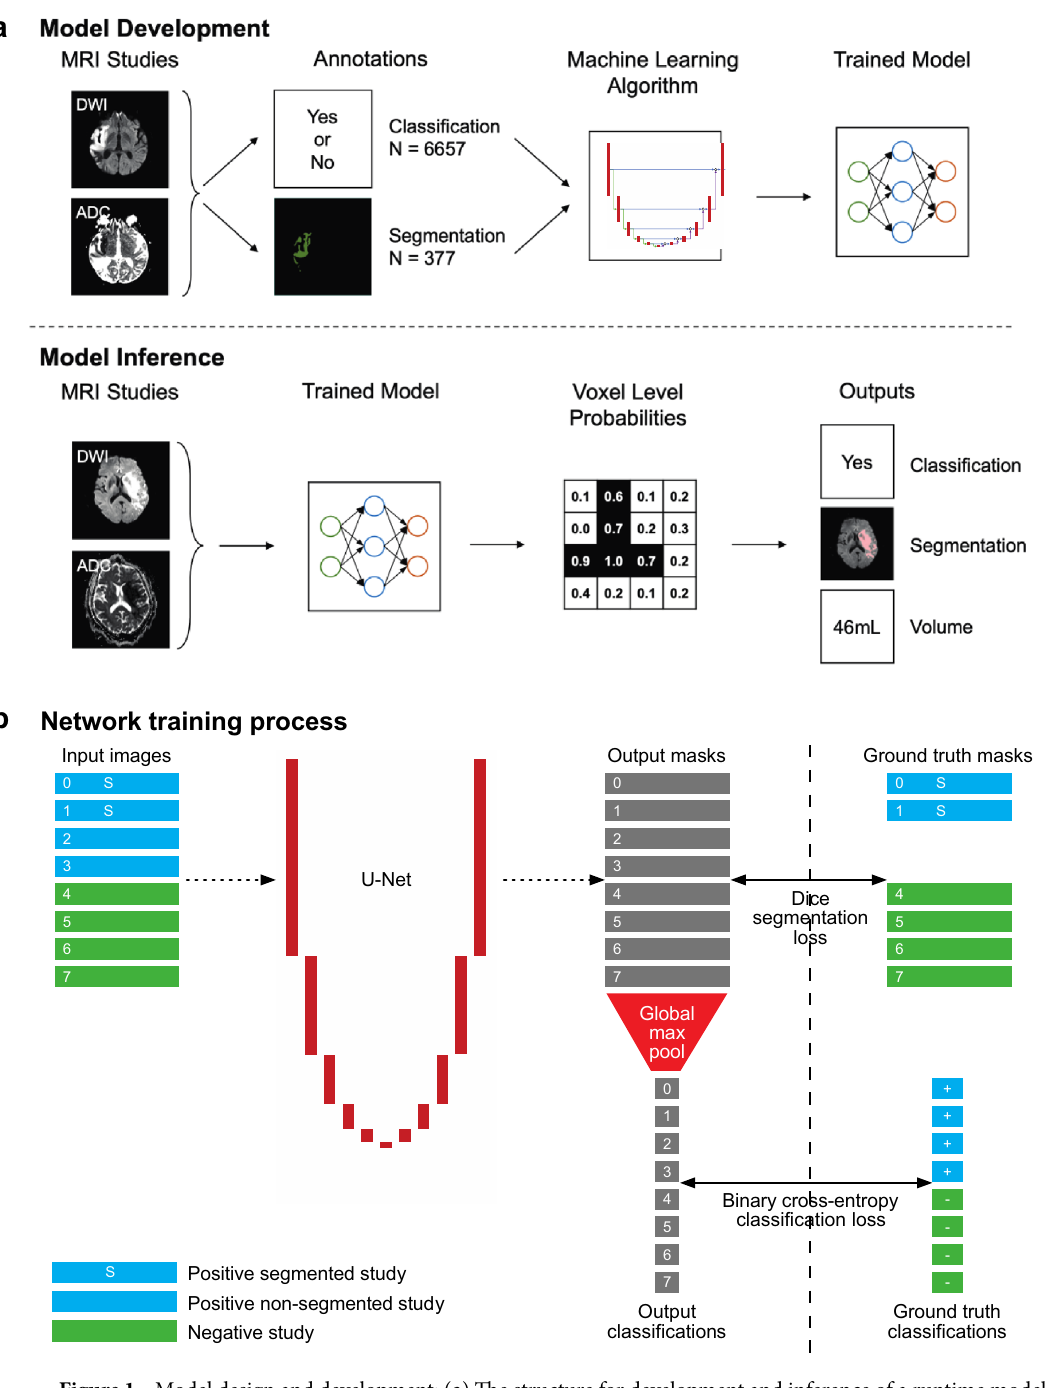
Figure 1. Model design and development: ( a ) The structure for development and inference of a runtime model including incorporation of both DWI and ADC sequences as well as both classification and segmentation annotations. The shading of voxel level probabilities uses an operating point of 0.5. ( b ) The training process for a single batch of DWI and ADC pairs from 8 studies. A batch consisted of 2 segmented positive studies, 2 non- segmented positive studies and 4 negative studies, which involved oversampling of segmented studies. A Dice segmentation loss was applied for the segmented positive studies and negative studies using the segmentation output masks. In addition to the segmentation output, a classification output was produced by a global max- pooling operation on the output masks. A binary cross-entropy loss was then applied for all examples in the batch using the classification